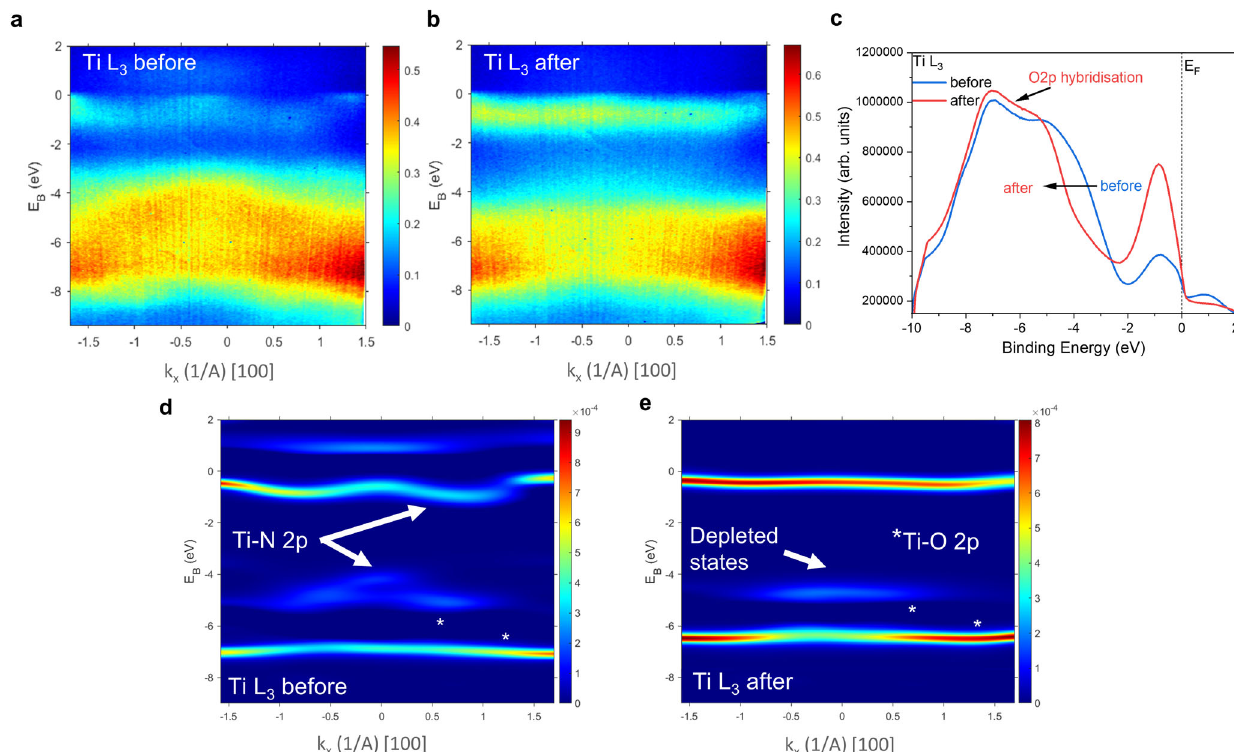
Fig. 3 Titanium B cation high-statistics ARPES data. a , b Ti L 3 -edge high-statistics ARPES images acquired at hv = 465.3 eV before ( a ) and after ( b ) the PECR. c Angle-integrated ARPES images from a , b , d , e the ARPES data from a , b represented in the second derivative -d 2 I /d E B 2 to enhance the band dispersions. The parallel Ti L 2 -edge data are included in Supplementary Fig.